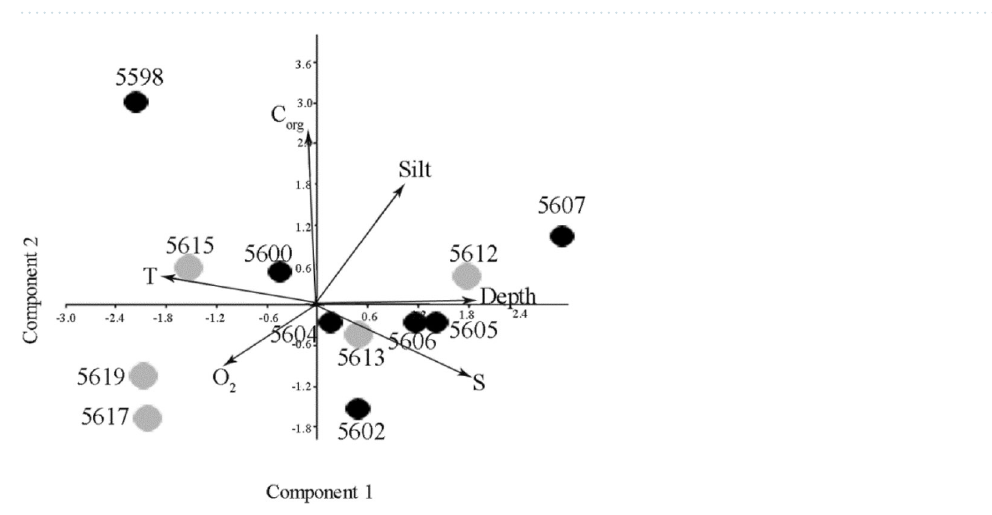
Figure 2. Discharge of the Kolyma ( a ) and Indigirka ( b ) Rivers in 2017. Data was obtained from the Arctic Great Rivers Observatory project web-site 62 .